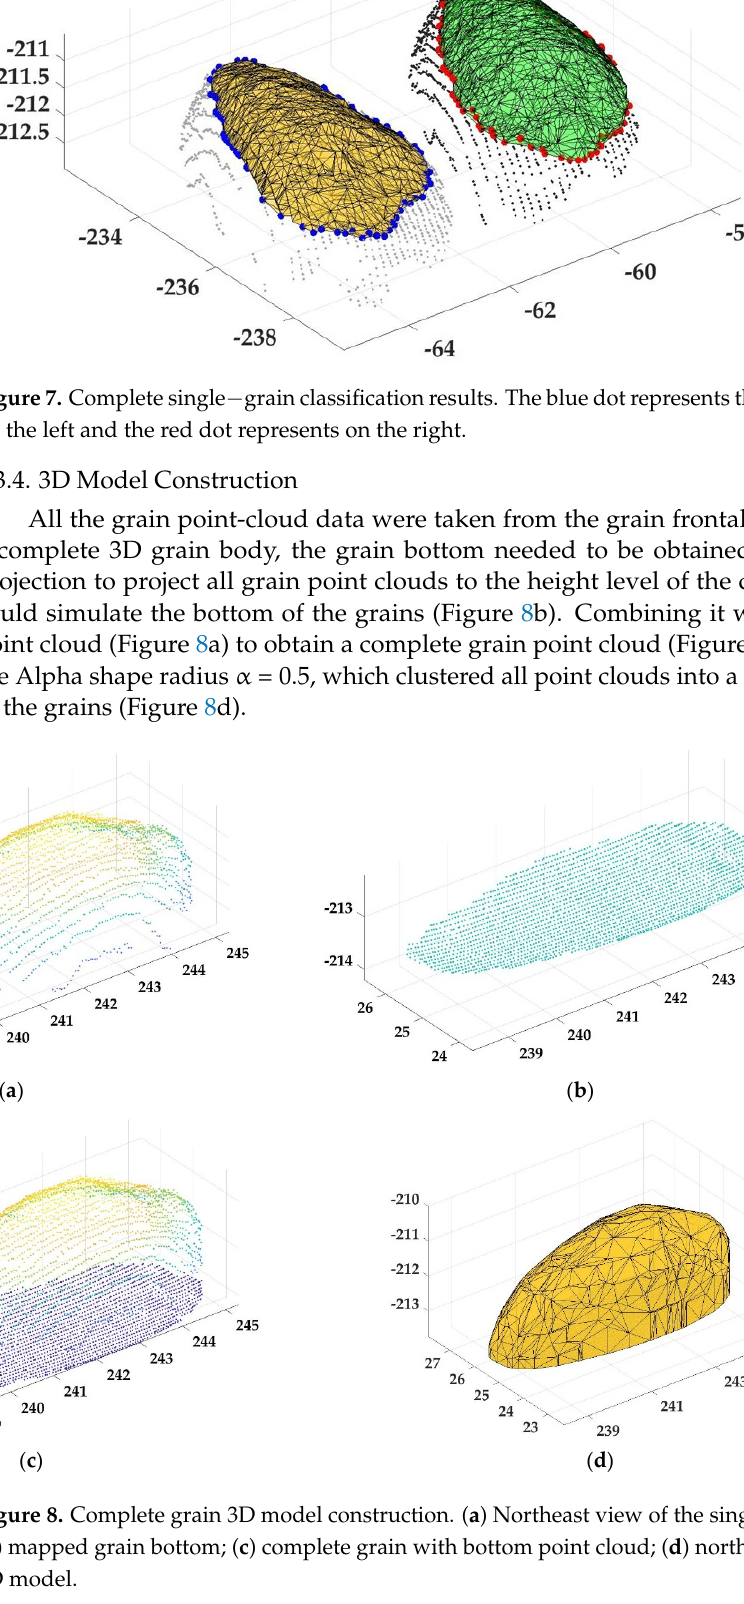
Figure 6. Single - rain point-cloud extraction. ( a ) All grain point clouds with segmented plane; ( b ) two grains’ point clouds and segmentation plane; ( c ) analysis of two grains’ point clouds and seg- mentation planes. The red line and green line indicate the distance between grains at different height levels.; ( d ) the upper part of the grain point cloud; ( e ) classification result of the upper part of dif- ferent grains.